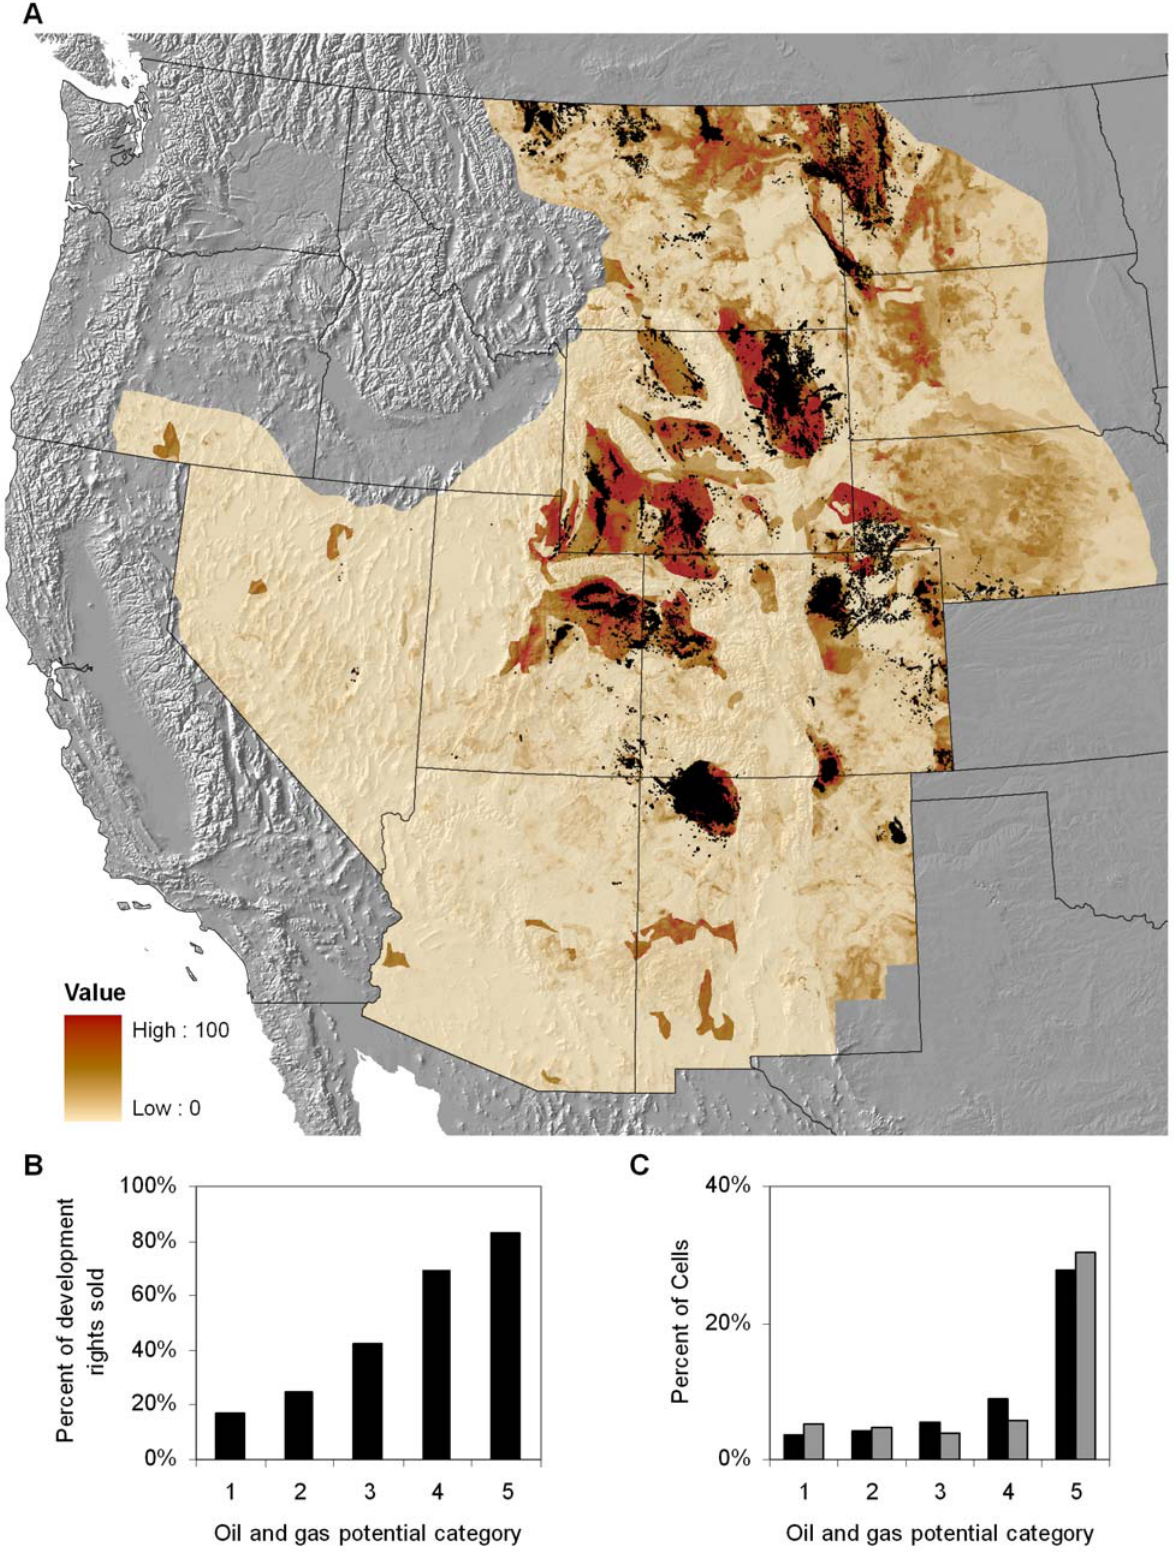
Figure 1. Oil and gas development potential in the US Intermountain West. (A) This map shows the potential for oil and gas development from low to high. Areas in red have the highest potential and tan have the lowest. Black dots show producing (active or inactive) well locations (IHS, Inc.). (B) Percent of federal minerals leased by oil and gas potential category (C) Validation of oil and gas potential model comparing predictions based on pre-1986 data to post-1986 wells drilled by quintile-derived oil and gas potential categories.